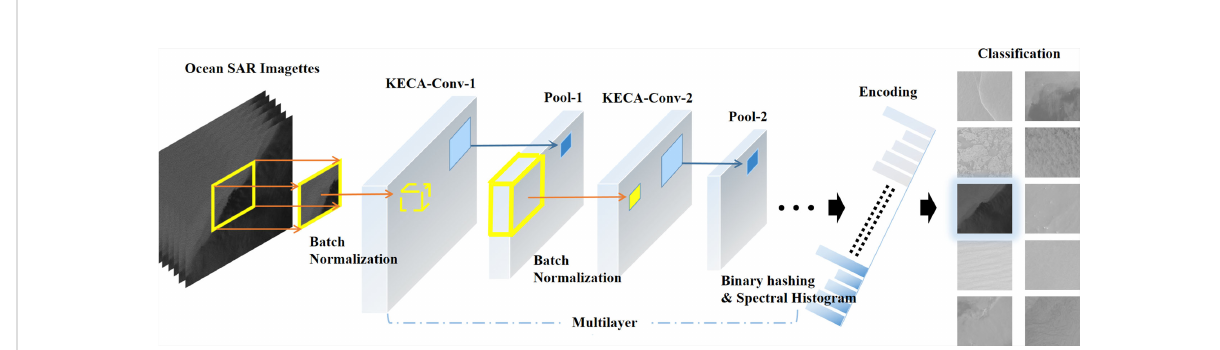
FIGURE 4 Architecture of the KECANet algorithm: batch normalization, multilayer convolution using KECA fi lters and mean pooling (nonlinearity), and SH feature encoding on layerwise feature